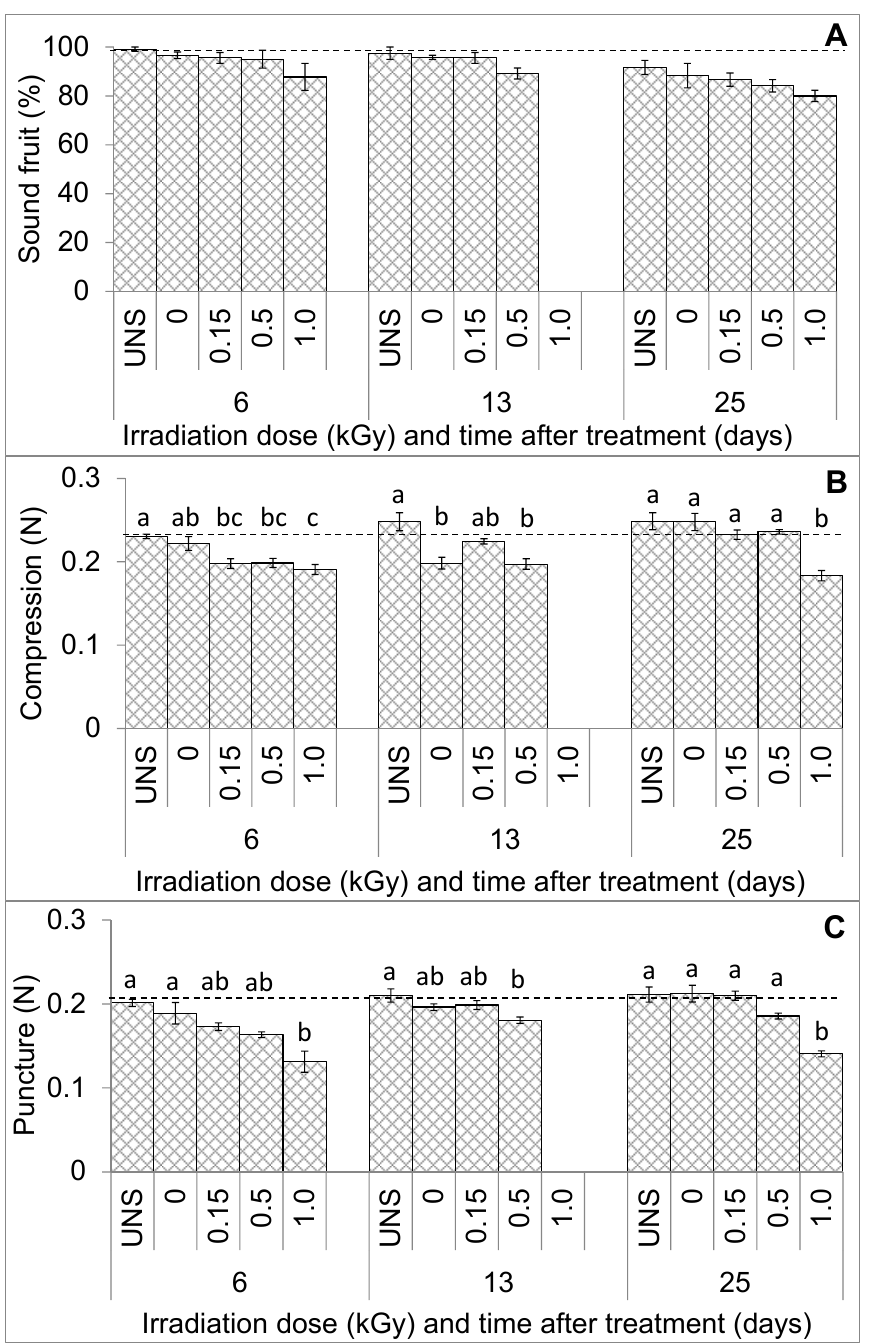
Figure 2. Effect of Electronic Cold-Pasteurization TM on percent sound fruit ( A ), compression ( B ), and puncture ( C ) for ‘Farthing’ blueberries in trial 2. Treatments included an unshipped control (UNS; not shipped to the irradiation facility) and four levels of irradiation; no irradiation control (0), 0.15, 0.5, and 1.0 kGy. Evaluations were conducted 6, 13, and 25 days after irradiation treatment. Fruit were stored at 2 to 4 °C under high relative humidity until assessments were performed. An initial fruit quality assessment was performed after harvest shown as a horizontal dashed line. Due to low number of fruit, measurements were not performed for fruit treated at 1 kGy at 13 days after treatment. Means within the same storage times after treatment followed by the same letter are not significantly different from each other based on one-way analysis of variance ( α =